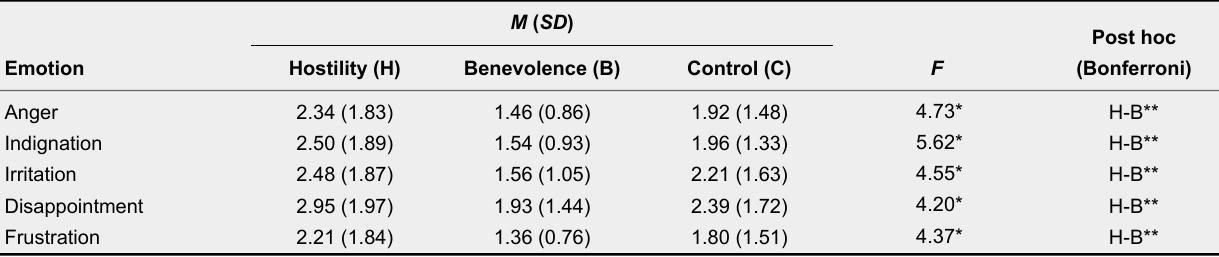
Sexist Attitudes Toward Men and the Experience of Negative